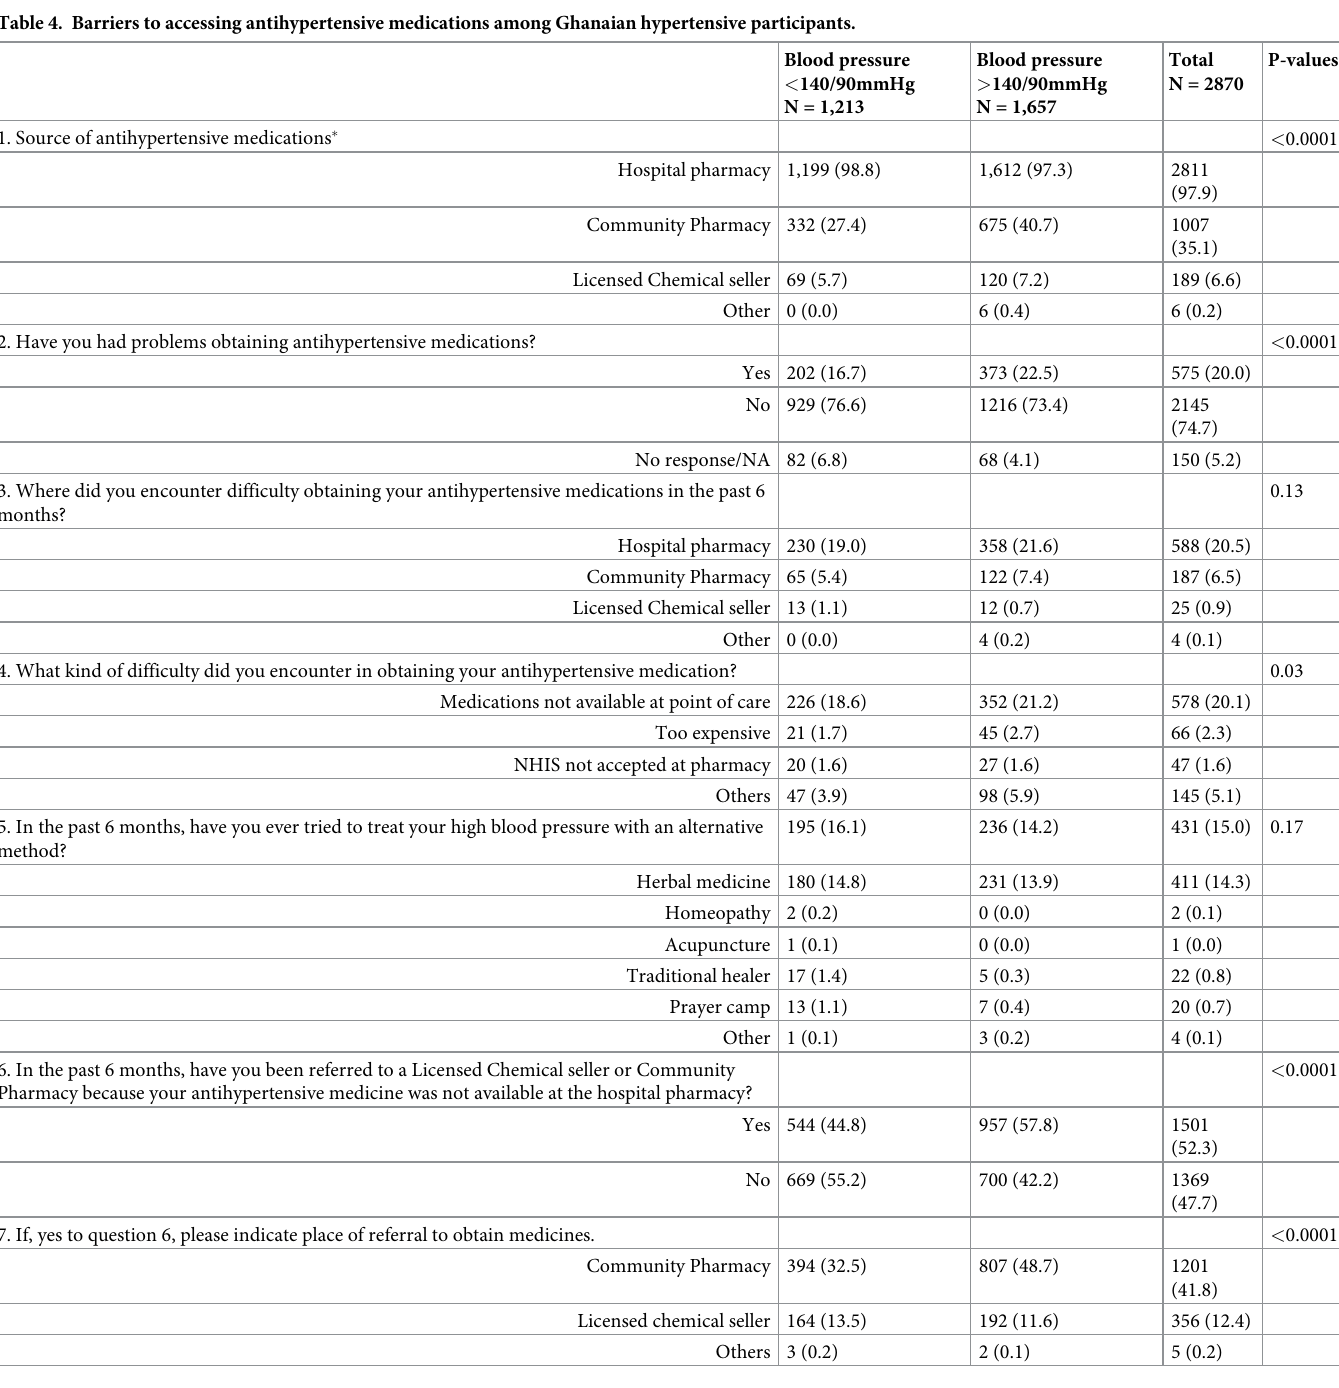
Table 4. Barriers to accessing antihypertensive medications among Ghanaian hypertensive